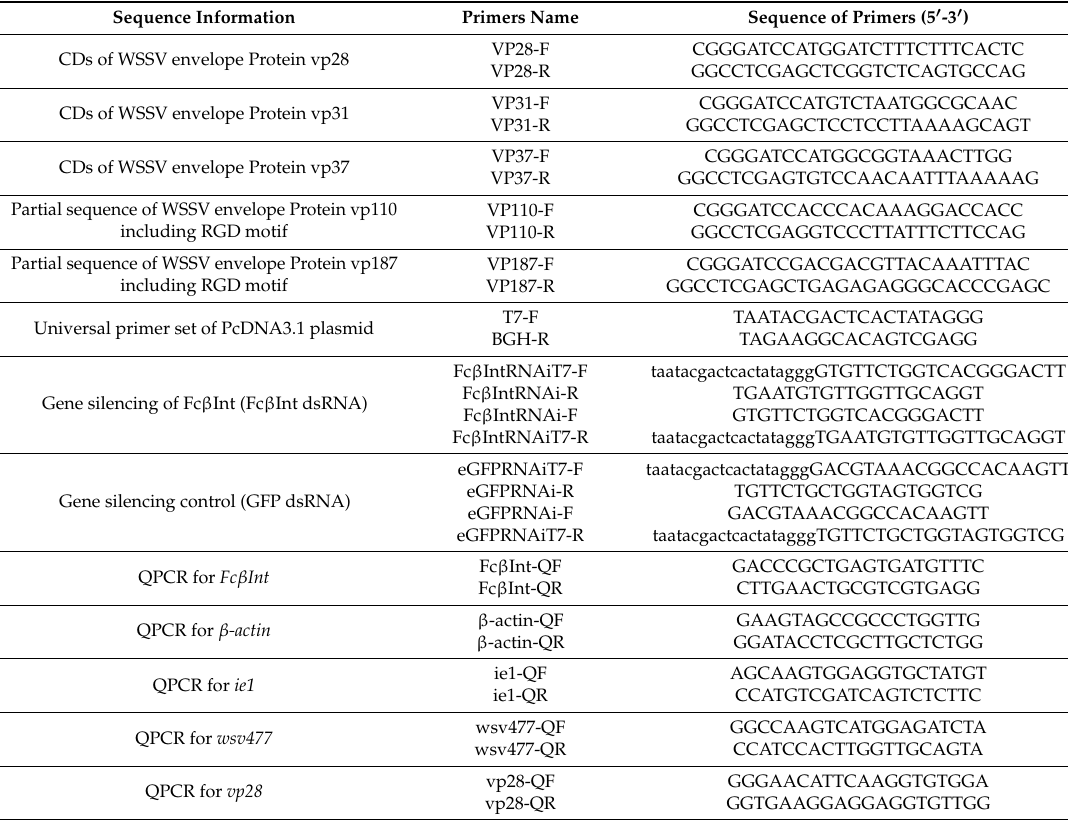
Table 1. Primers used in this